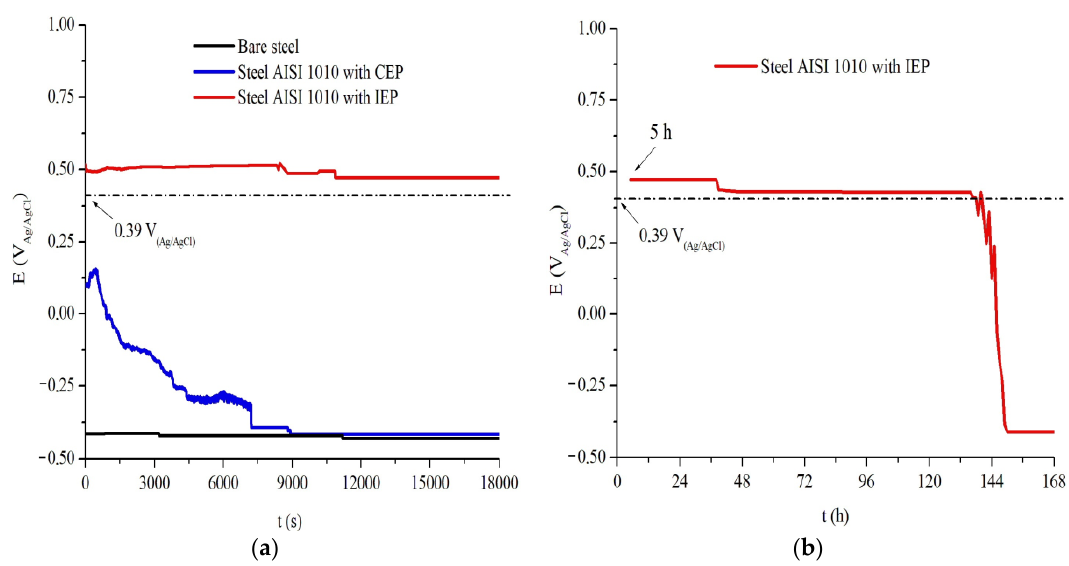
Figure 7. OCP vs. time ( a ) AISI 1010 steel without and with CEP, IEP coatings exposed to 2 mol L −1 H 2 SO 4 solution for a period of 18,000 s; ( b ) AISI 1010 steel with IEP coatings exposed to 2 mol L −1 H 2 SO 4 solution for a period of 168 h. The dotted line at 0.39 V Ag/AgCl indicates the Flade potential for steel in this medium.